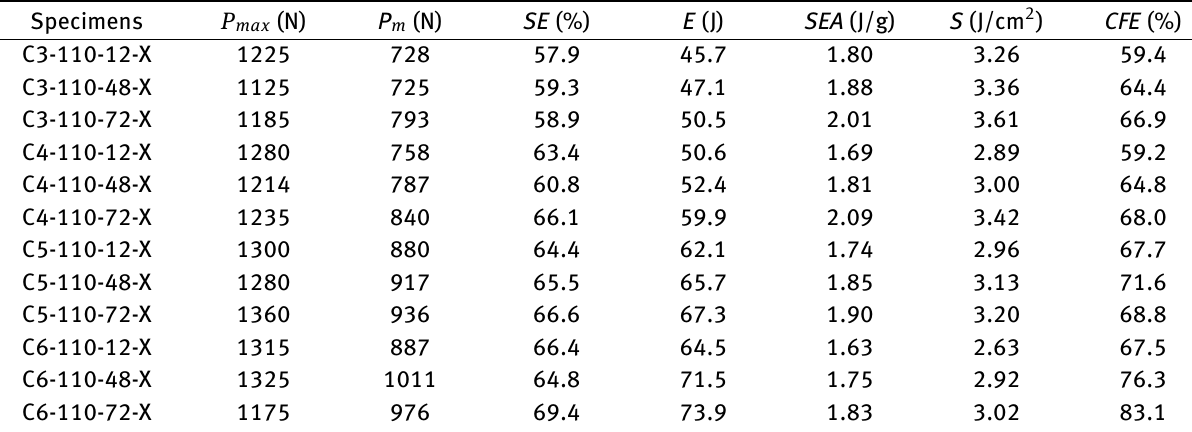
Table 2: Cushioning energy absorption of paper corrugation tubes along X direction Specimens